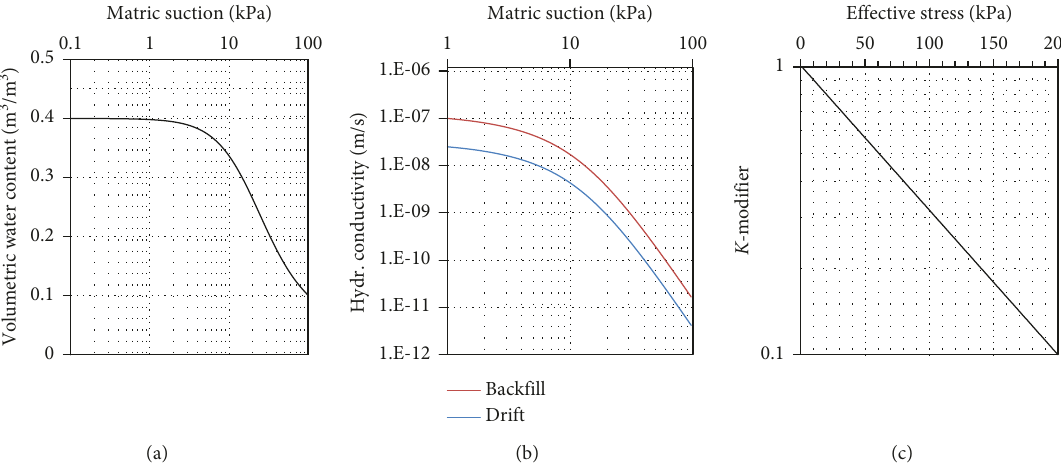
Figure 2: Hydraulic properties applied to the unsaturated backfill and interface elements: (a) water retention curve of the backfill; (b) hydraulic conductivity function for the backfill in the stop and in the drift; (c) k -modifier function which is applied on the k function following backfill consolidation.